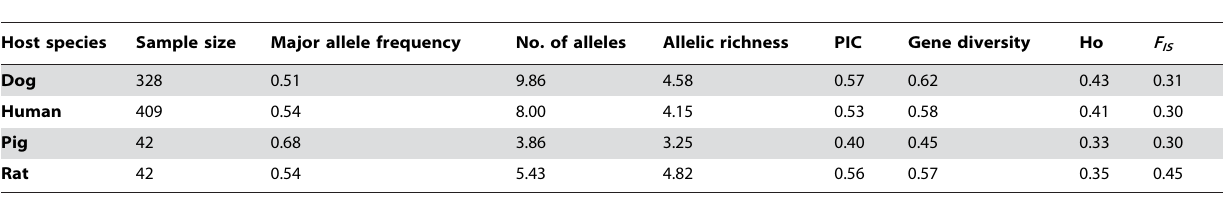
Table 3. Summary statistics for Schistosoma japonicum population isolates across host species.